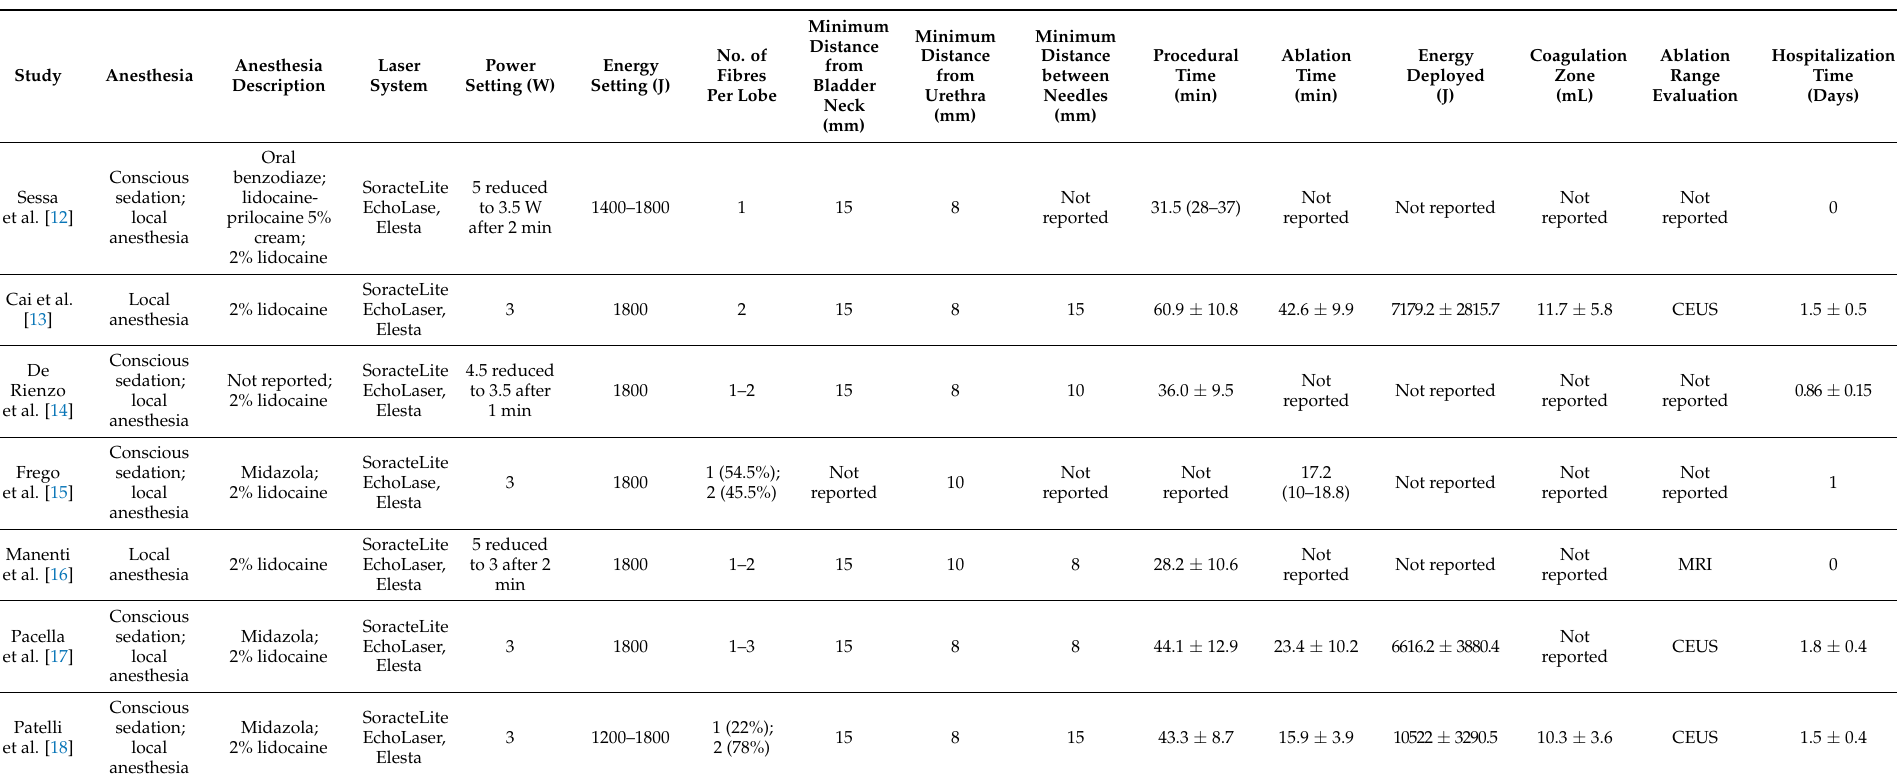
Table 2. Operative and perioperative features and details of technique of studies on Trans Perineal Laser Ablation (TPLA) of prostate included in this